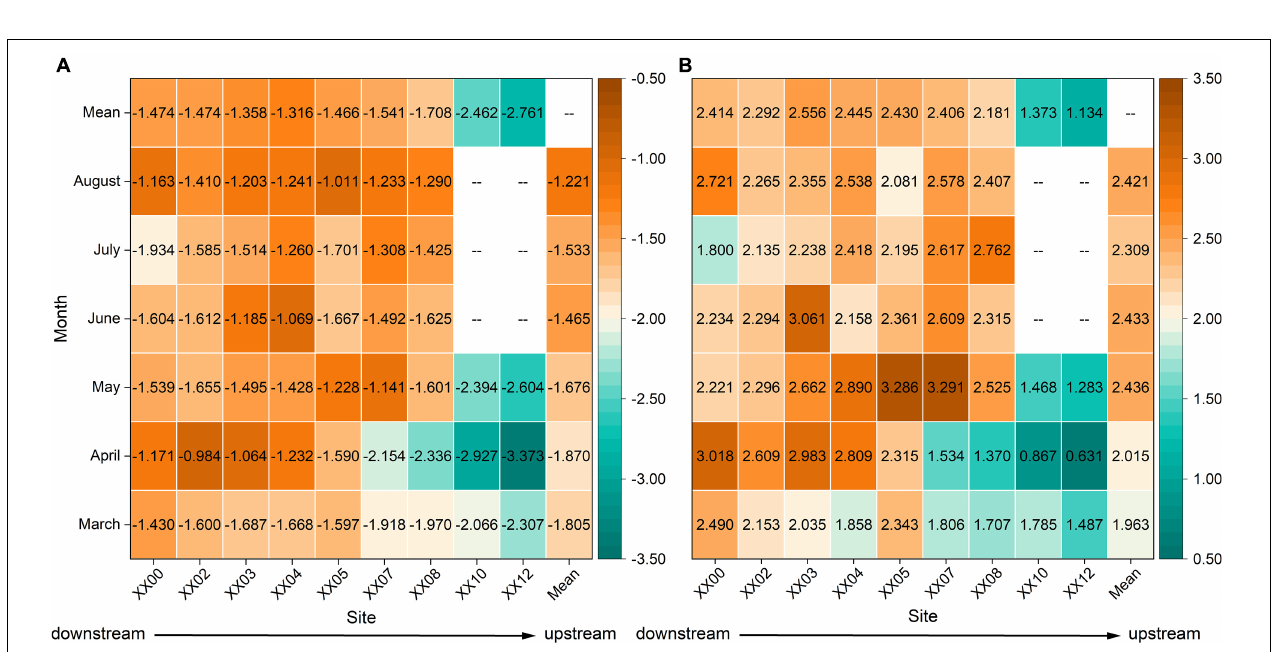
FIGURE 5 | Spatiotemporal variations of zooplankton size spectrum (A) , and zooplankton size diversity (B) in the Xiangxi Bay of Three Gorges Reservoir.